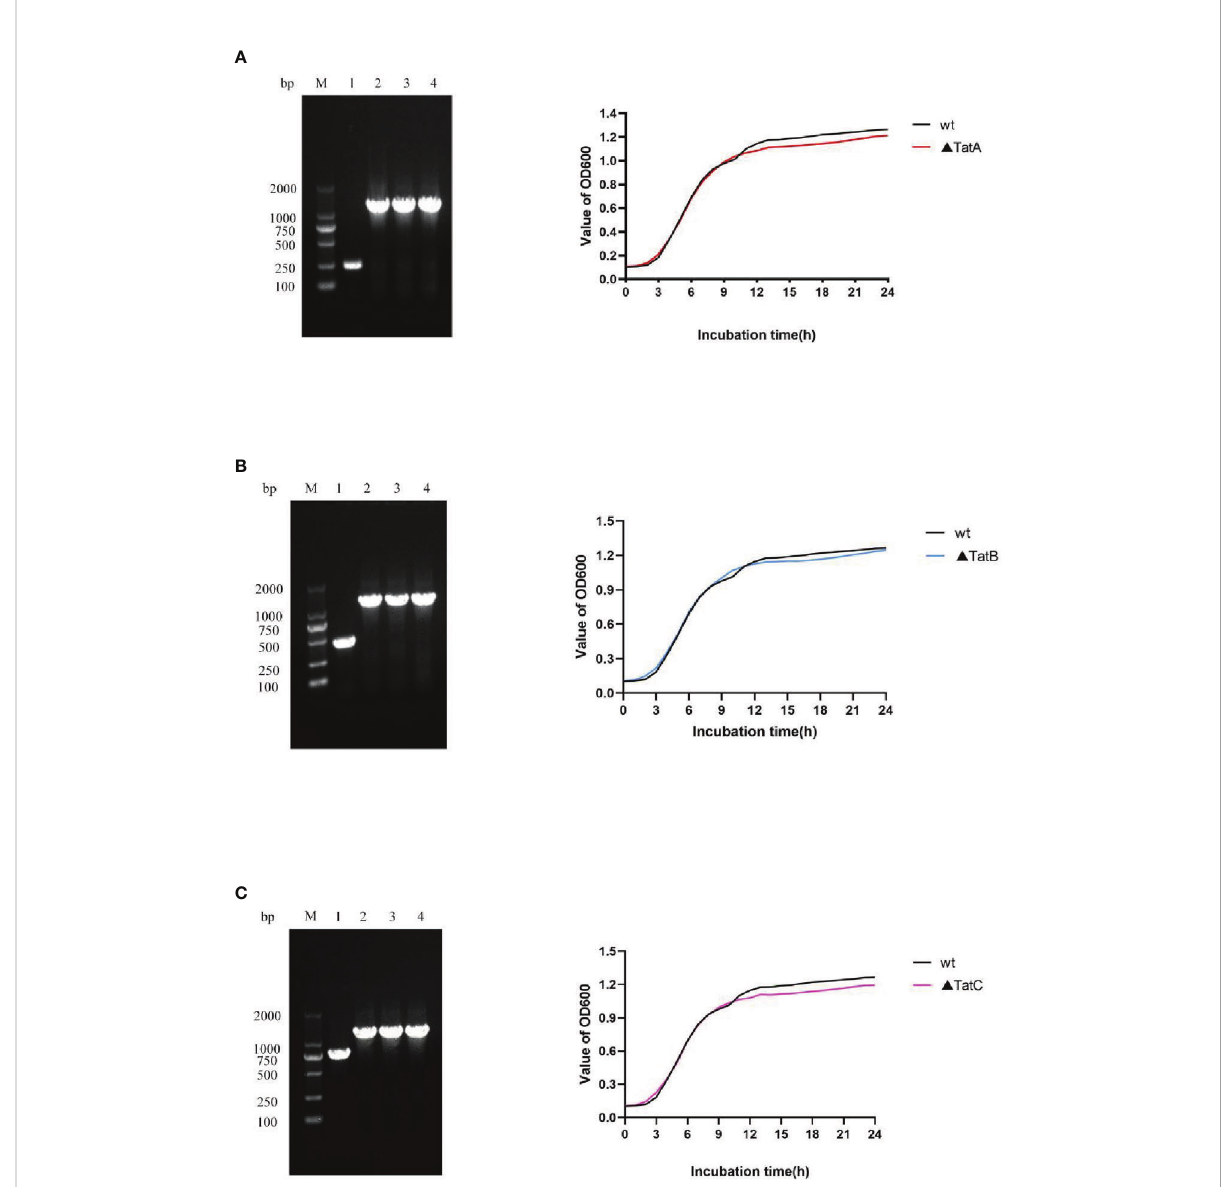
FIGURE 9 Construction and growth curve of D tatA , D tatB , and D tatC strains of A. salmonicida, Lane M: DNA molecular weight markers; Lanel 1: PCR products of wild strain; Lane 2 - 4: PCR products of tatA mutant (A) , PCR products of tatB mutant (B) , PCR products of tatC mutant (C)